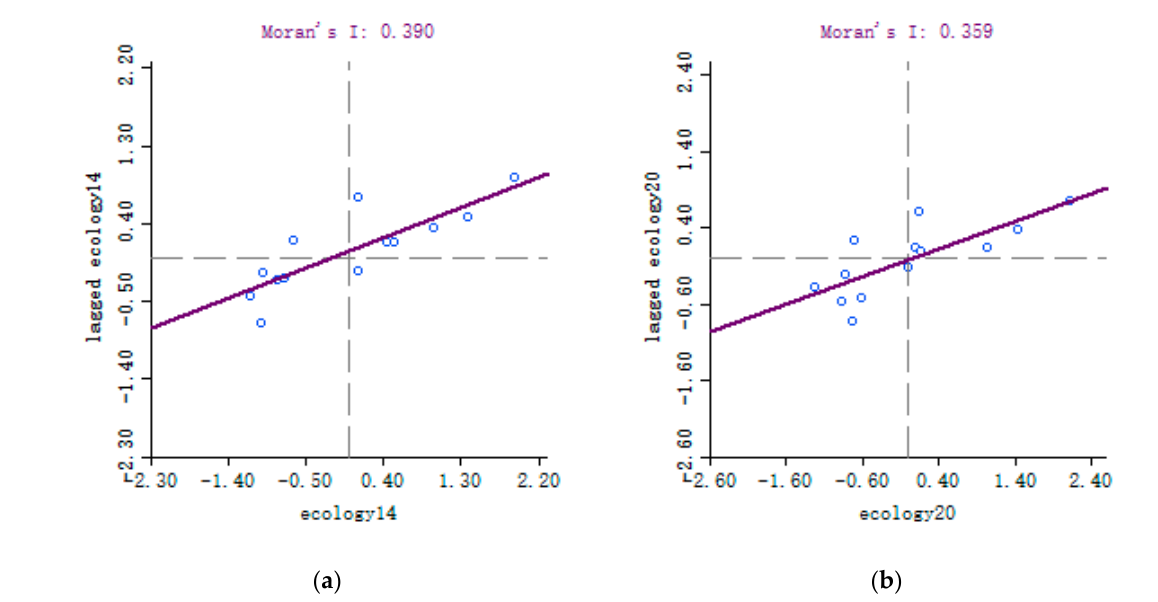
Figure 2. Moran’s I scatterplot of ecological level in Wuhan City. ( a ) 2014. ( b ) 2020. In order to show the test results more clearly, the ecological level LISA map of Wuhan city was drawn. According to Figure 3, there were only high/high areas, low/low areas, and insignificant results. Since 2014, only Hongshan District and Dongxihu District were high/high areas with high ecological level, whereas Jianghan District, Jiang’an District, Qiaokou District, Qingshan District, Hanyang District, and Wuchang District were low/low areas with a low ecological level. Jiangxia District and Hannan District remained insignificant, whereas Xinzhou District changed in some years. For example, Xinzhou Dis- trict was not significant in 2014 and 2015, but became an HH area after 2015.